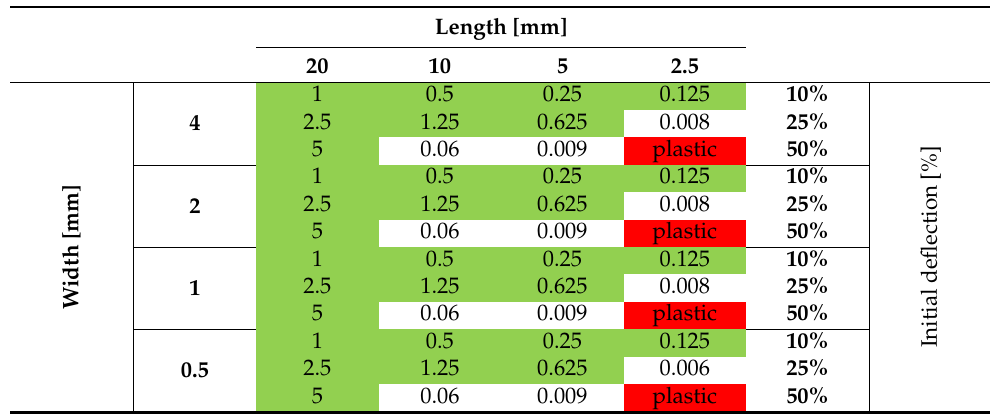
Table 2. Results of initial length/width tests for constant voltage of 1